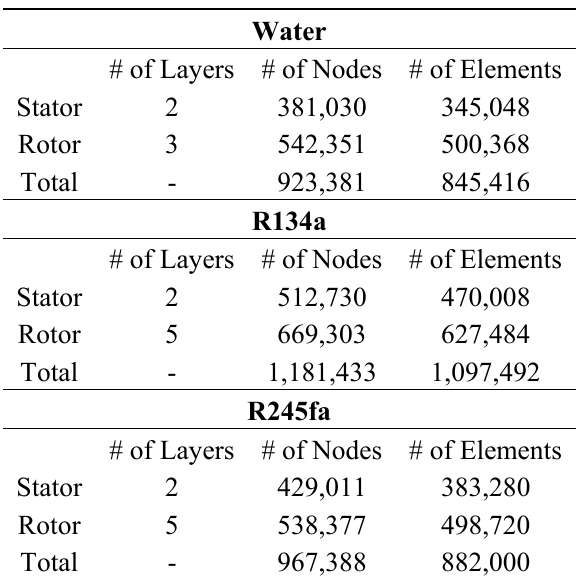
Table 6. CFD mesh data.